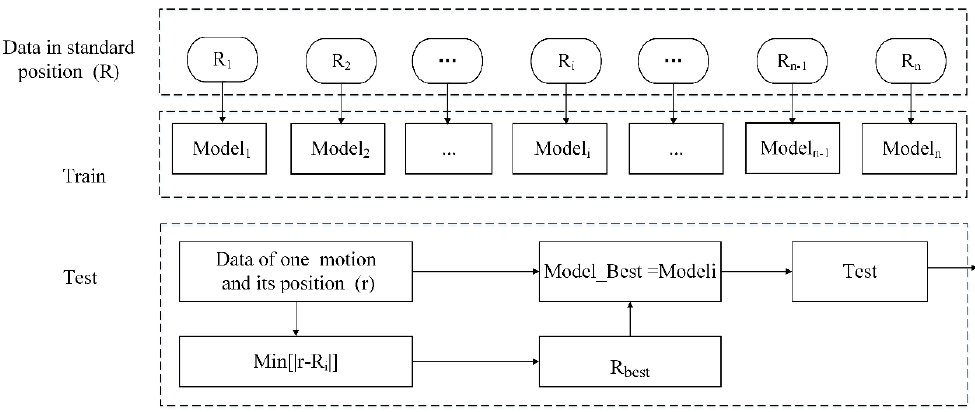
Figure 8. Operation diagram of OS-SVM based on prior human position information.